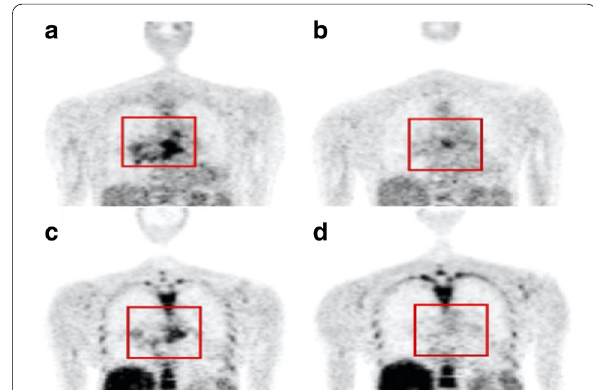
Fig. 4 Evaluating response to erlotinib therapy with [ 18 F]FDG-PET and [ 18 F]FLT-PET. [ 18 F]FDG-PET ( a ) and [ 18 F]FLT-PET ( c ) before start of treatment, and [ 18 F]FDG-PET ( b ) and [ 18 F]FLT-PET ( d ) after 1 week of treatment with erlotinib. [ 18 F]FDG uptake is higher than [ 18 F] FLT in the baseline scans. Erlotinib treatment decreases uptake of both radiotracers. The [ 18 F]FLT scan after therapy shows minimal uptake indicating that erlotinib is effectively inhibiting proliferation. Reprinted with permission from JNM. This research was originally published in JNM. Kahraman et al.